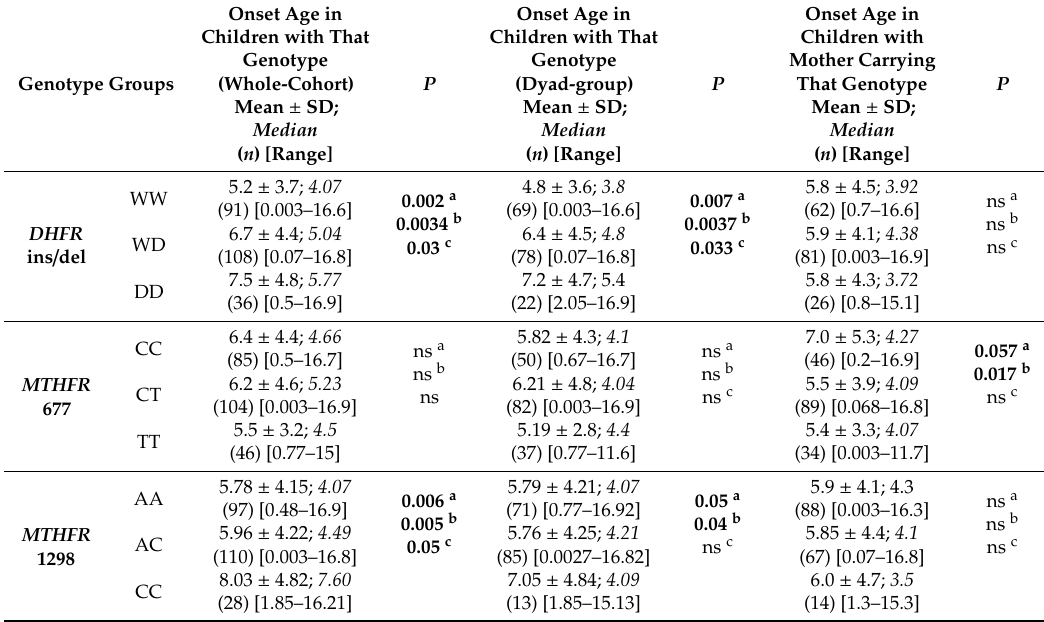
Table 2. Age of ALL (acute lymphoblastic leukemia) onset according to di ff erent children and mothers